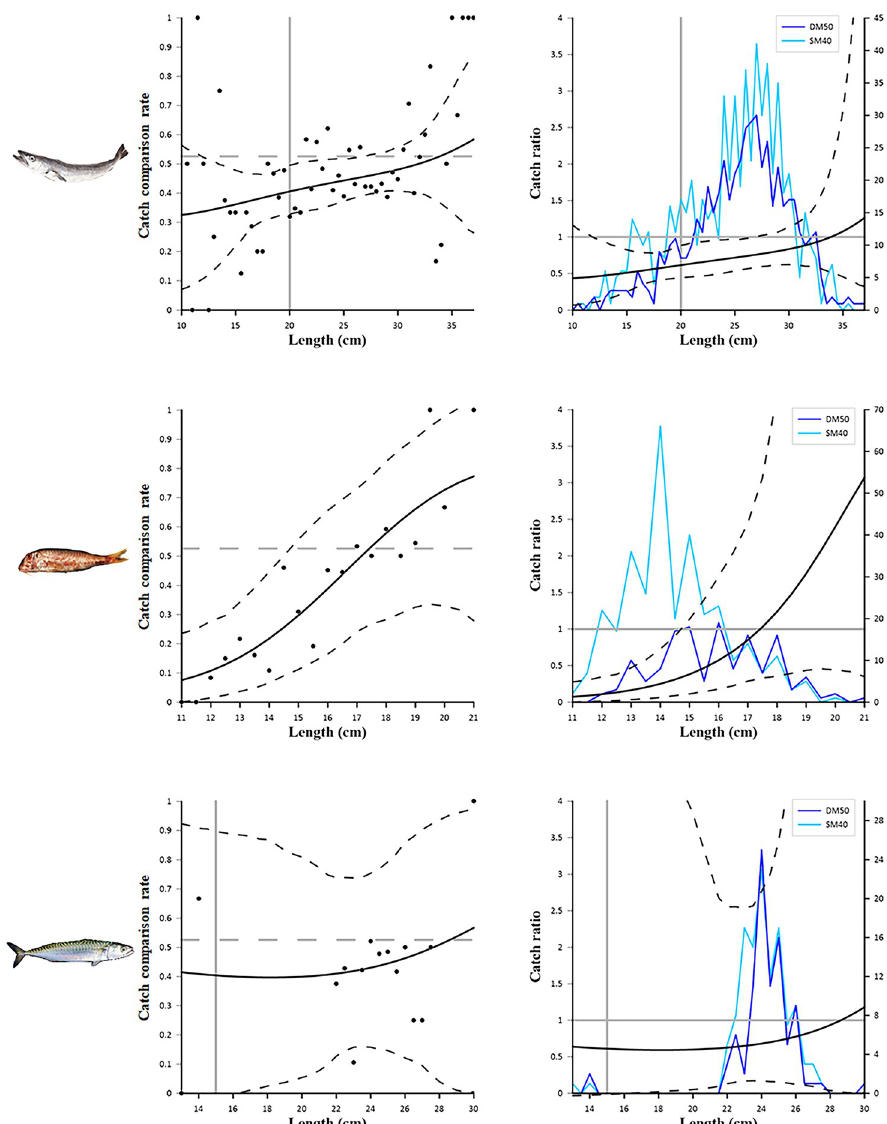
Fig 5. Results of the catch comparison analyses obtained for Merluccius merluccius (top), Mullus barbatus (middle) and Scomber scombrus (bottom). The graphs on the left show the modelled catch comparison rate (black line) with 95% CI (black stippled curves); the black circles represent the experimental rate; the grey horizontal line at 0.526 represents the point at which both configurations have equal catch rates; the grey vertical lines represent the MCRS of the species. The graphs on the right show the catch ratio (black line) with 95% CI (black stippled curves); the blue lines represent the length frequency distributions obtained with the two codends tested (DM50 and SM40); the grey horizontal line at 1.0 represents the point at which both configurations have equal catch rates; the grey vertical line represents the MCRS of the species. also from the length frequency distributions obtained. No individuals below 11 cm, which represents the MCRS of the species, were caught in the sea trials. Regarding the Atlantic mackerel (Fig 5, bottom), there are no significant differences between the catch efficiency of the two codends, since the CI s of both the catch ratio and catch comparison curves over- lapped, for the full length range measured, the horizontal 0.526 line representing equal catch rates. The low number of individuals caught during the sea trials are reflected in the